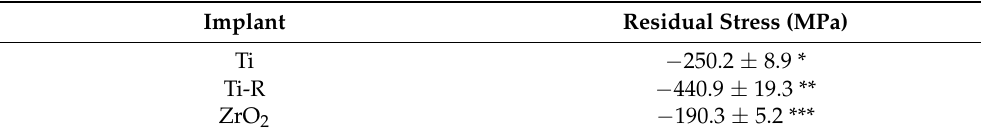
Table 4. Surface residual stresses calculated at the four different types of Ti dental implant surfaces.